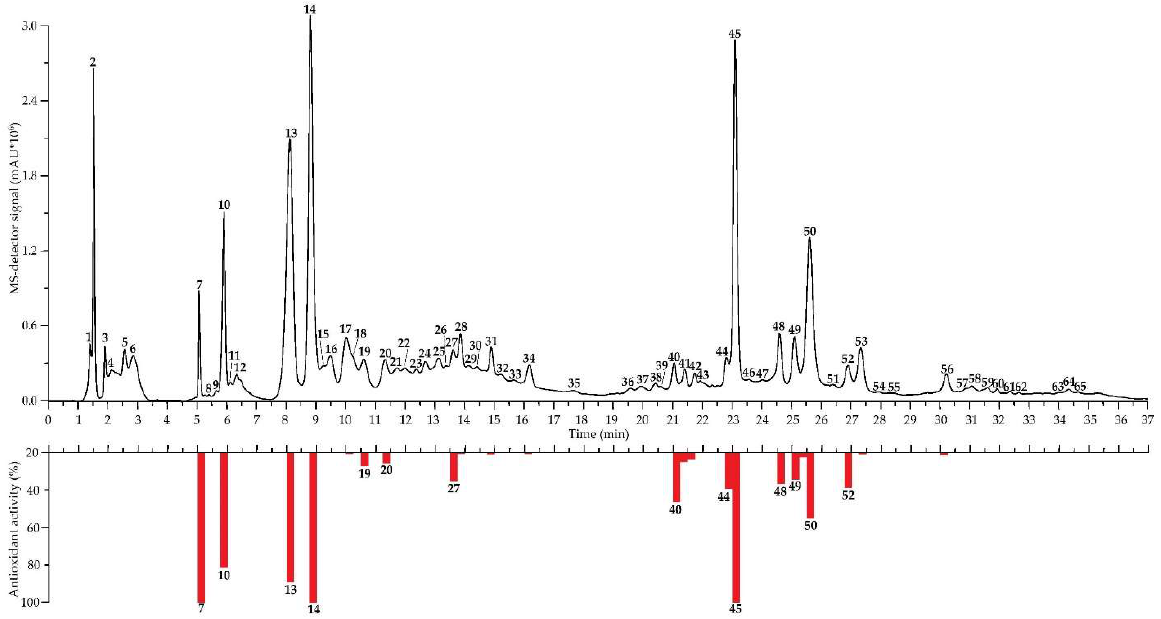
Figure 4. High-performance liquid chromatography with electrospray ionization triple quadrupole mass spectrometric detection (HPLC-ESI-tQ-ESI-MS) chromatogram (base peak intensity chromatogram, negative ionization) of an extract of F. orientalis fruit (on top; compounds are numbered as listed in Table 2) and 2,2-diphenyl-1-picrylhydrazyl radical (DPPH • ) scavenging activity of the HPLC fraction of F. orientalis fruit extract. Red bars show the antiradical activity (as percentage) in the probe after reaction with the DPPH • radical